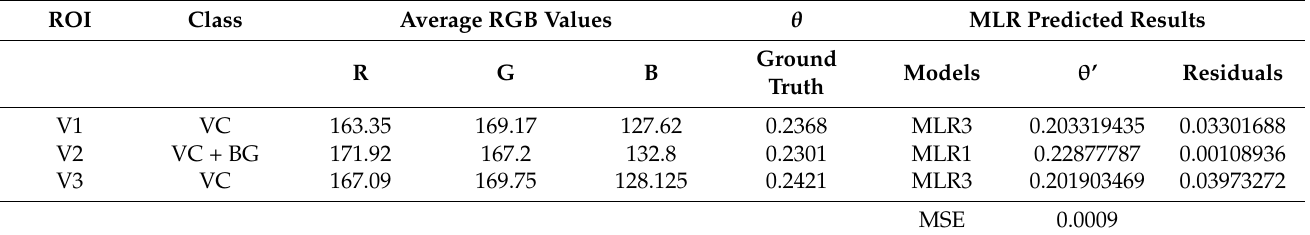
Table 11. MLR model validation